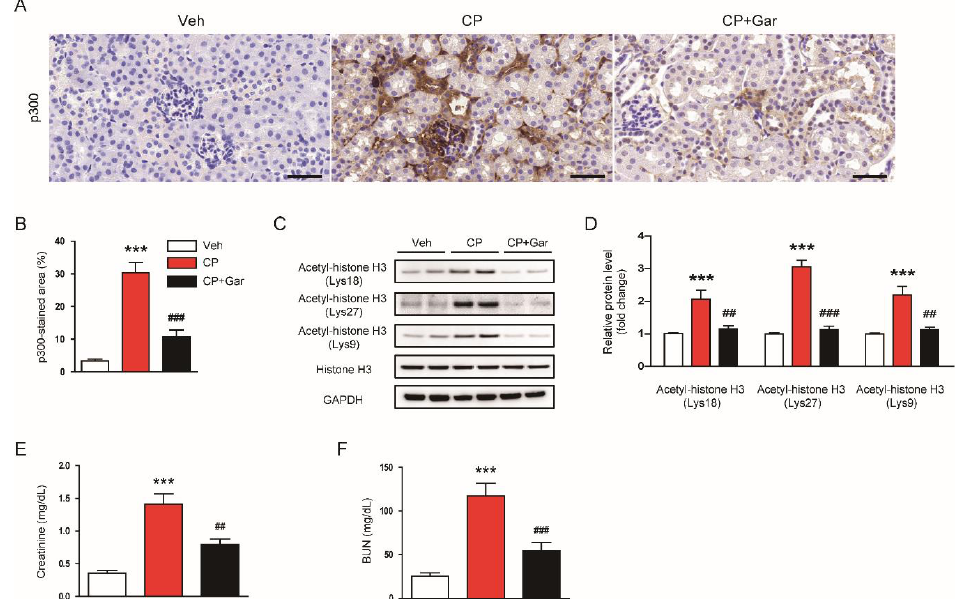
E ff ect of garcinol on p300 expression, histone acetylation, and renal function in cisplatin-injected mice. Mice were given an intraperitoneal administration with garcinol (10 mg / kg; Gar) daily for four consecutive days, starting from one day prior to cisplatin treatment. All mice were sacrificed 72 h after cisplatin treatment. ( A ) Immunohistochemical staining of kidney tissues for p300. Scale bar = 50 µ m. ( B ) Percentage of stained areas for p300. ( C ) Immunoblottings of acetyl-histone